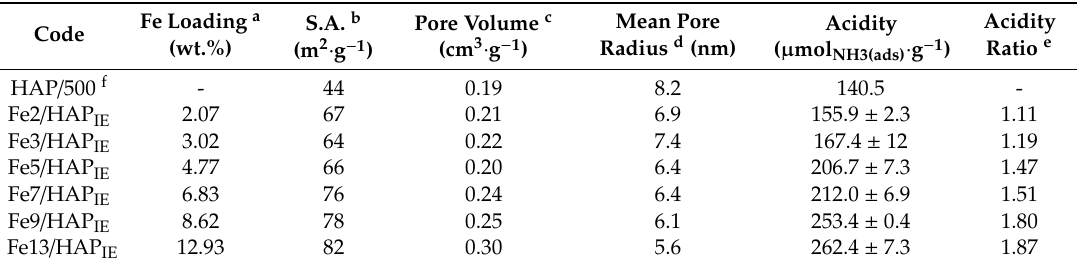
Table 1. Main morphological and surface properties of all the Fe / HAP samples compared with those of bare HAP calcined at 500 ◦